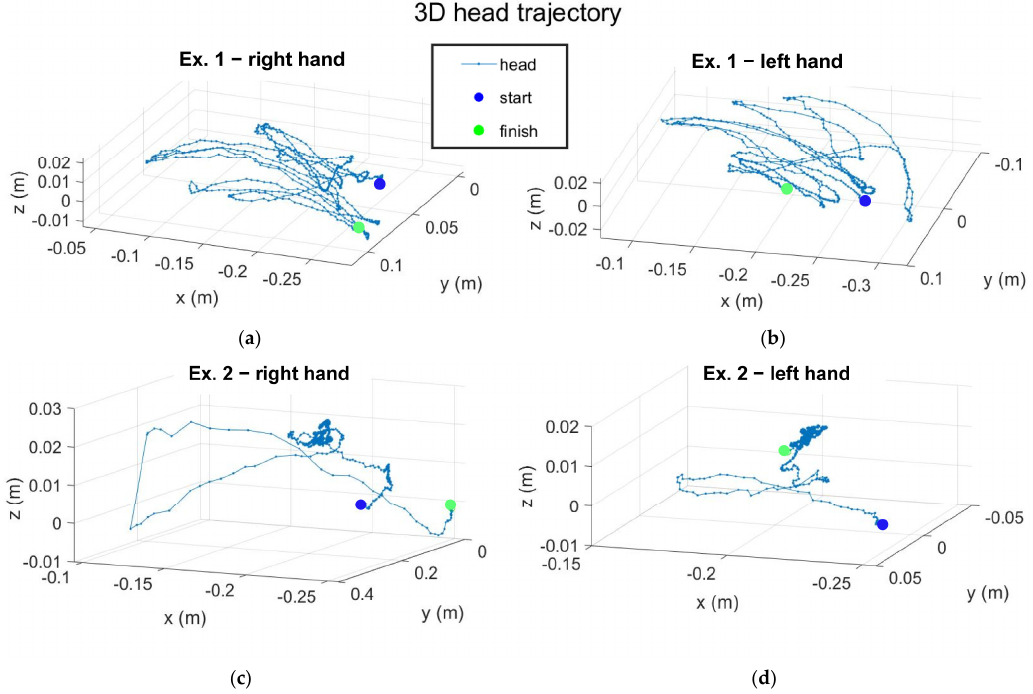
Figure 5. Graphs of the trajectories of the subject’s head: ( a ) trajectory during exergaming 1 performed with the right hand, ( b ) trajectory during exergaming 1 performed with the left hand, ( c ) trajectory during exergaming 2 performed with the right hand, ( d ) trajectory during exergaming 2 performed with the left hand.